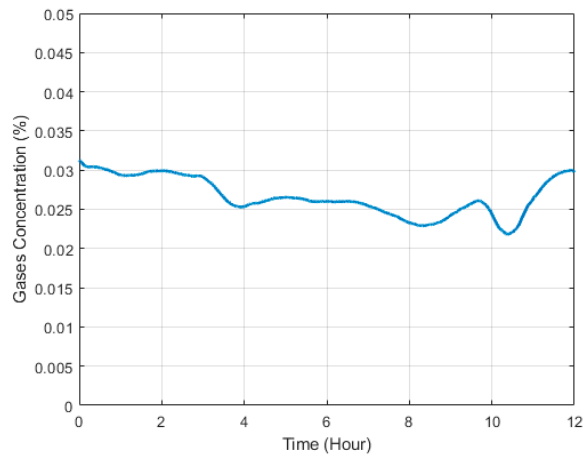
Figure 9. Tree’s surrounding gases concentration [%] evolution over time—Experimental test 1.